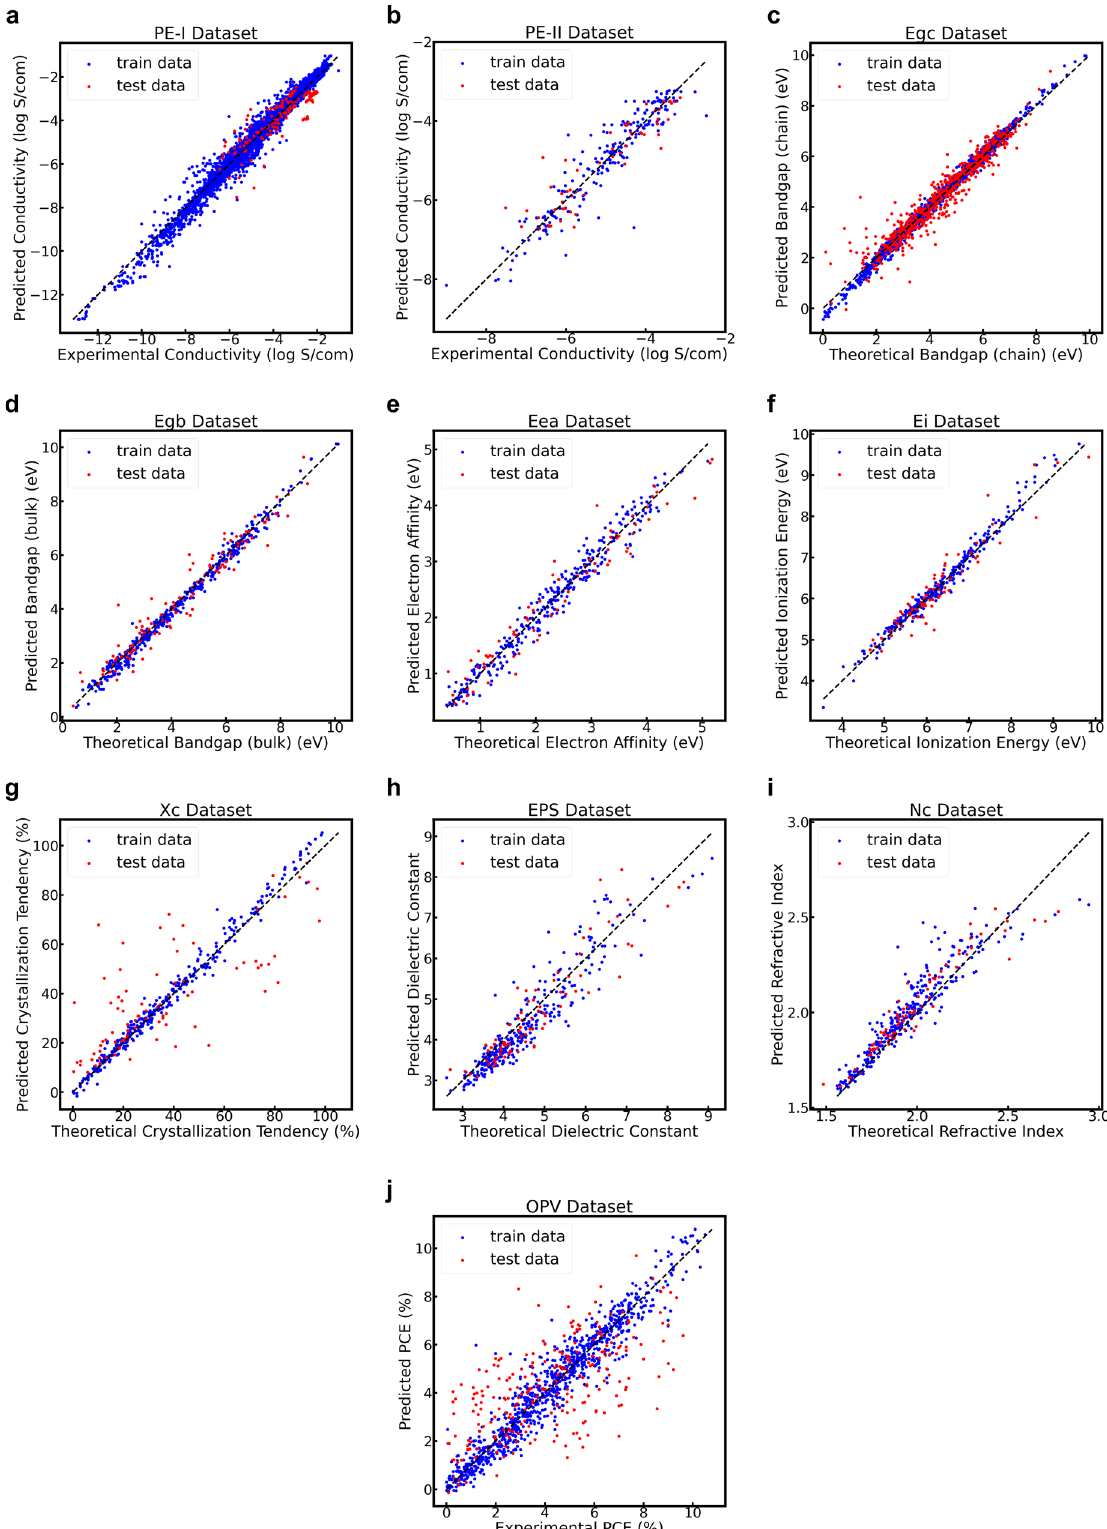
Fig. 2 Ground truth vs. predicted values by TransPolymer pretrained . Scatter plots of ground truth vs. predicted values for downstream tasks: a PE-I, b PE-II, c Egc, d Egb, e Eea, f Ei, g Xc, h EPS, i Nc, and j OPV. The dashed lines on diagonals stand for perfect